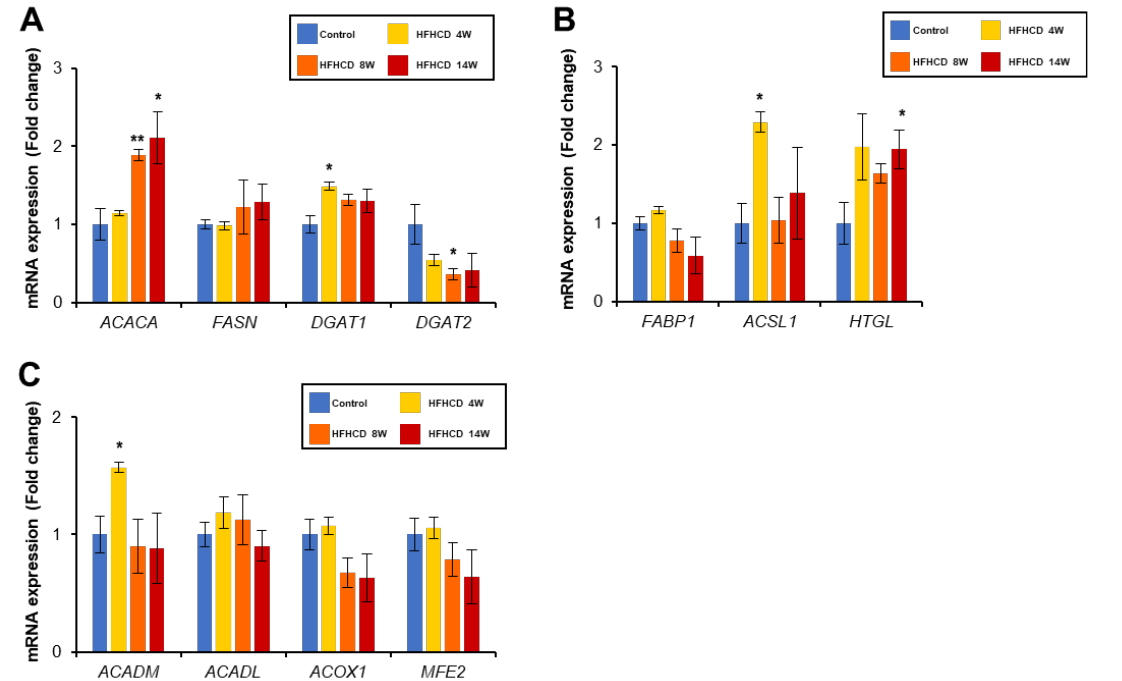
Figure 4. The changes in the gene expression of TG metabolism in HFHCD-fed rabbit livers. Hepatic mRNA levels of genes related to fatty acid/TG synthesis ( A ), TG transport ( B ), and β -oxidation ( C ) were quantified using real-time PCR and normalized to GAPDH. Data are shown as the mean ± SEM. * p < 0.05, ** p < 0.01 vs. control group. Control group (12 weeks, n = 3), HFHCD group; 4 weeks (n = 3), 8 weeks (n = 4), 14 weeks (n = 4).